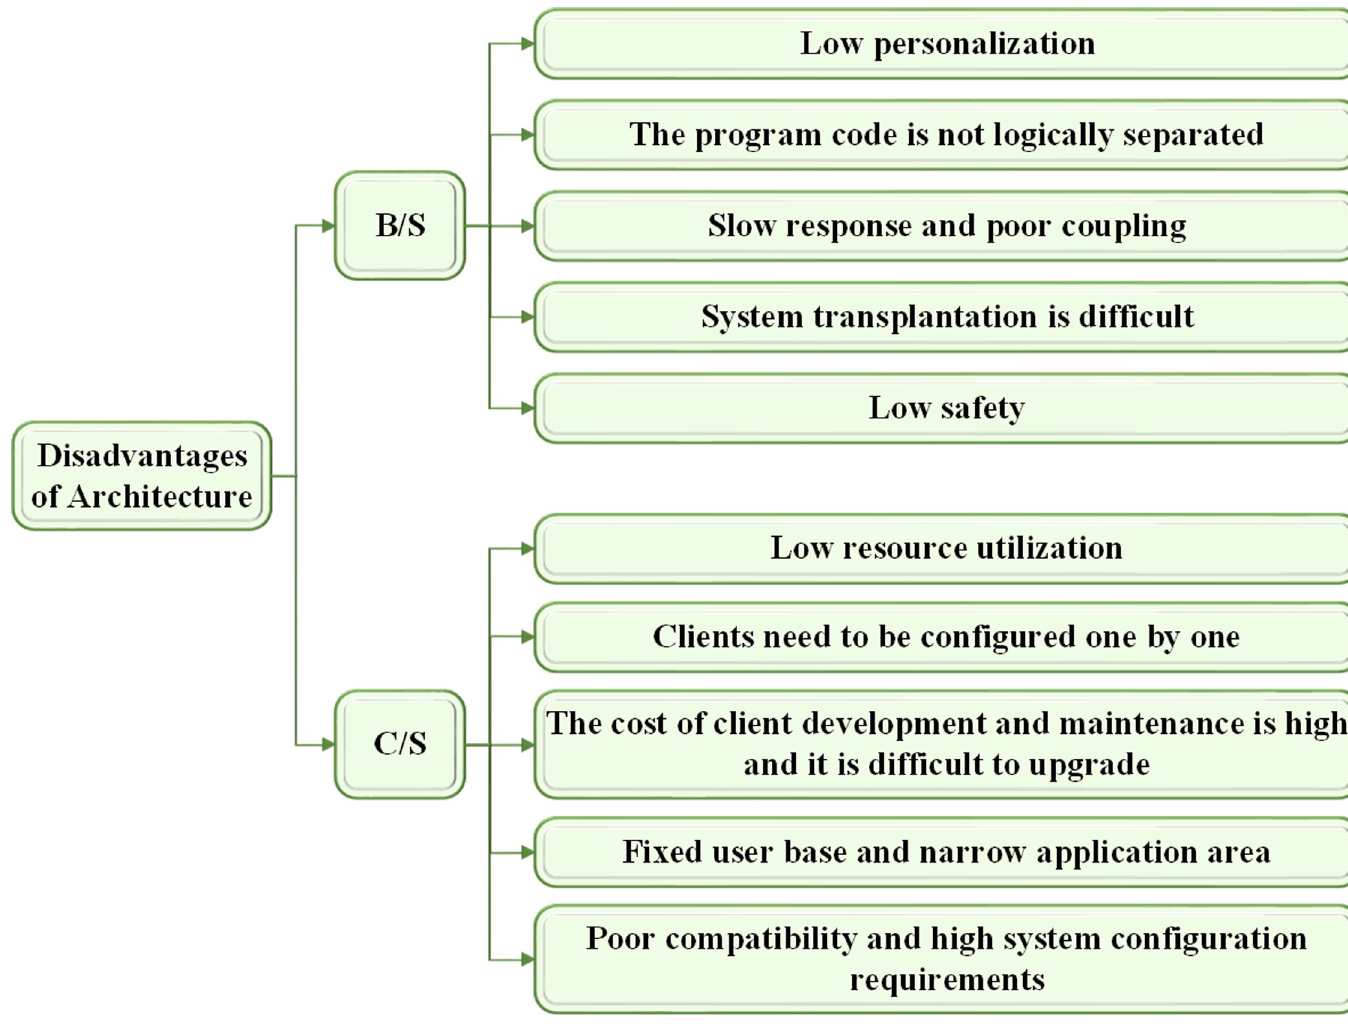
Fig 4. Comparison between disadvantages of B/S architecture with C/S